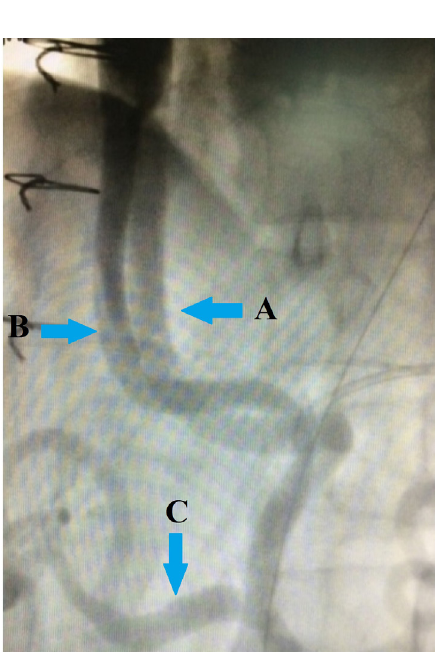
Fig. 5 - Angiographic view of Y-graft which perfused superior mesenteric artery and celiac artery. A) Dacron Y-graft from the ascending aorta to the celiac artery; B) Dacron Y-graft from the ascending aorta to the superior mesenteric artery; C) celiac artery